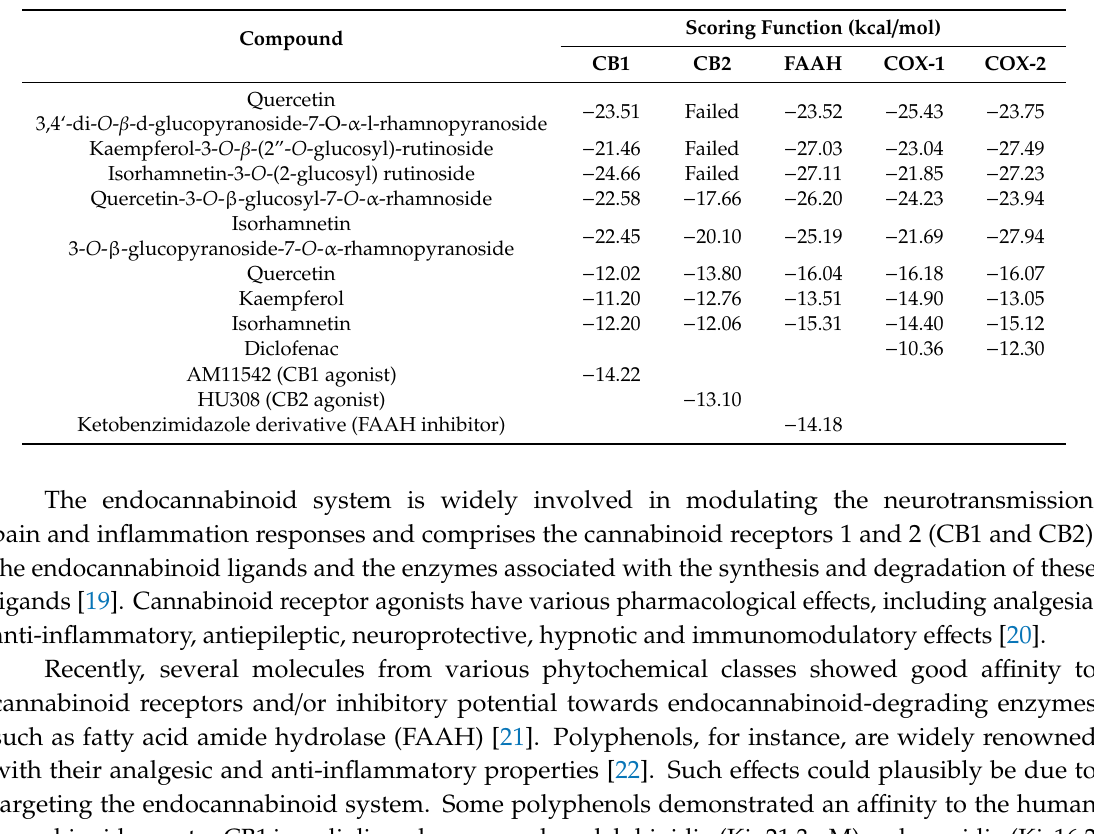
Table 7. Scoring functions of the docking poses of the major compounds from the MS-3 fraction of M. sinaica docked to the cannabinoid receptors CB1 and CB2 and fatty acid amide hydrolase (FAAH) and cyclooxygenase (COX-1 and COX-2)